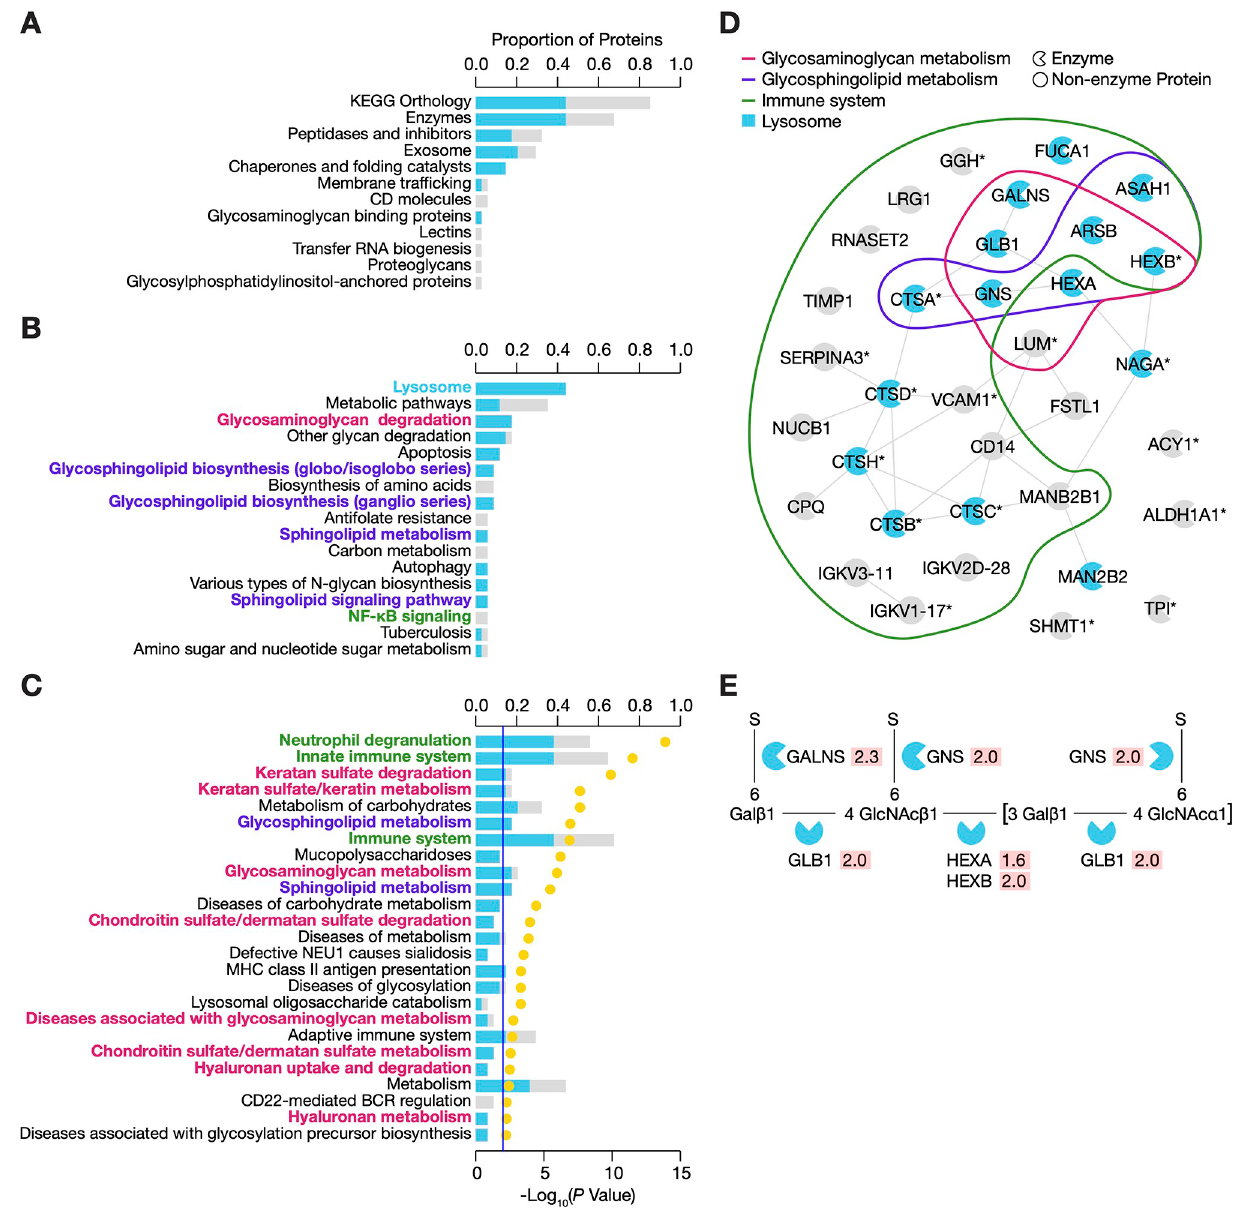
Fig 3. Lysosomal enzymes involved in glycosaminoglycan metabolism and the immune system dominated the urinary signature of early type 1 diabetes. (A) Top KEGG functional hierarchies associated with the signature proteins. Stacked bars indicate the proportions of lysosomal (blue) and non-lysosomal (grey) proteins in the urinary signature. (B) Top KEGG pathways associated with two or more signature proteins. Stacked bars indicate the proportions of lysosomal (blue) and non-lysosomal (grey) proteins in the urinary signature. (C) Enriched Reactome pathways associated with signature proteins ( P < 0.05). Stacked bars indicate the proportion of lysosomal (blue) and non-lysosomal (grey) proteins in the urinary signature and correspond with the left axis. Dots represent statistical significance and correspond with the right axis. (D) Protein-protein interaction network of urinary signature proteins. Clusters highlight protein involvement in glycosaminoglycan metabolism, glycosphingolipid metabolism, and immune system. Blue colour indicates a protein associated with the lysosome. (E) Visualization of the reactions and enzymes involved in keratan sulfate degradation. Fold changes (relative to youths without diabetes) are shown on a red background next to each